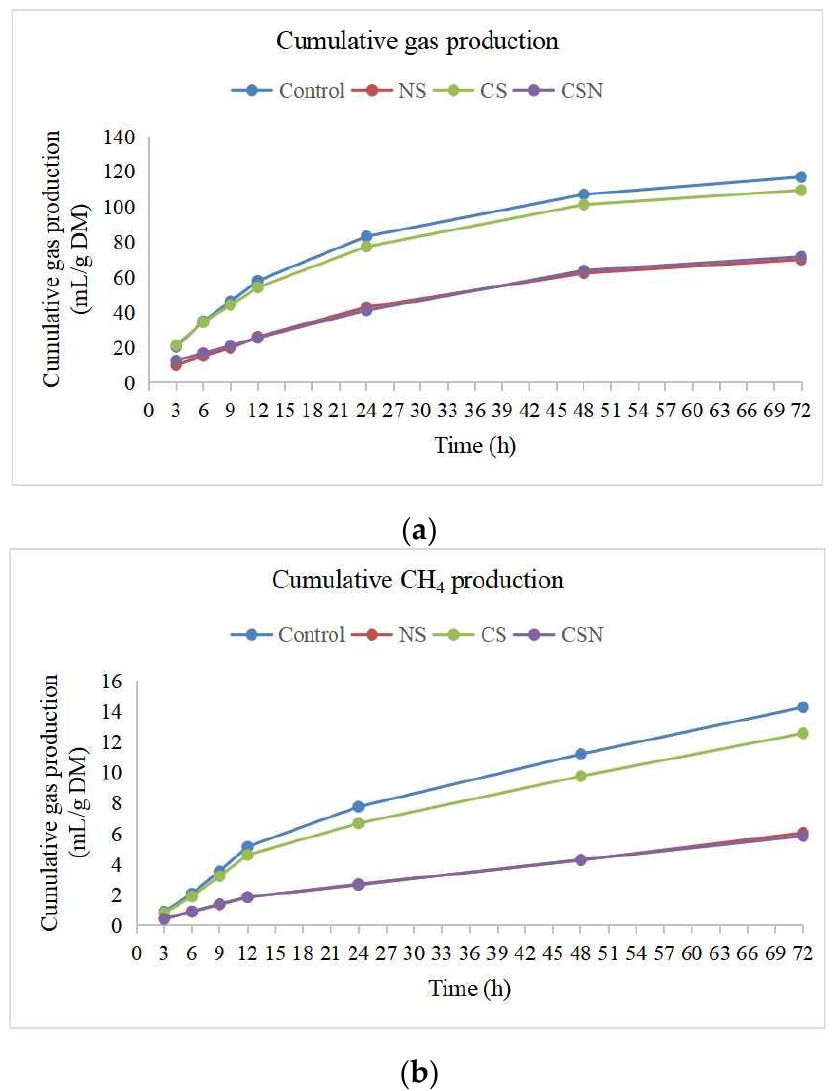
Figure 1. Cumulative gas production ( a ) and cumulative CH 4 production ( b ) at different time intervals. Table 3. Effects of sodium nitrate (SN), cysteamine hydrochloride(CS), and combination of CS